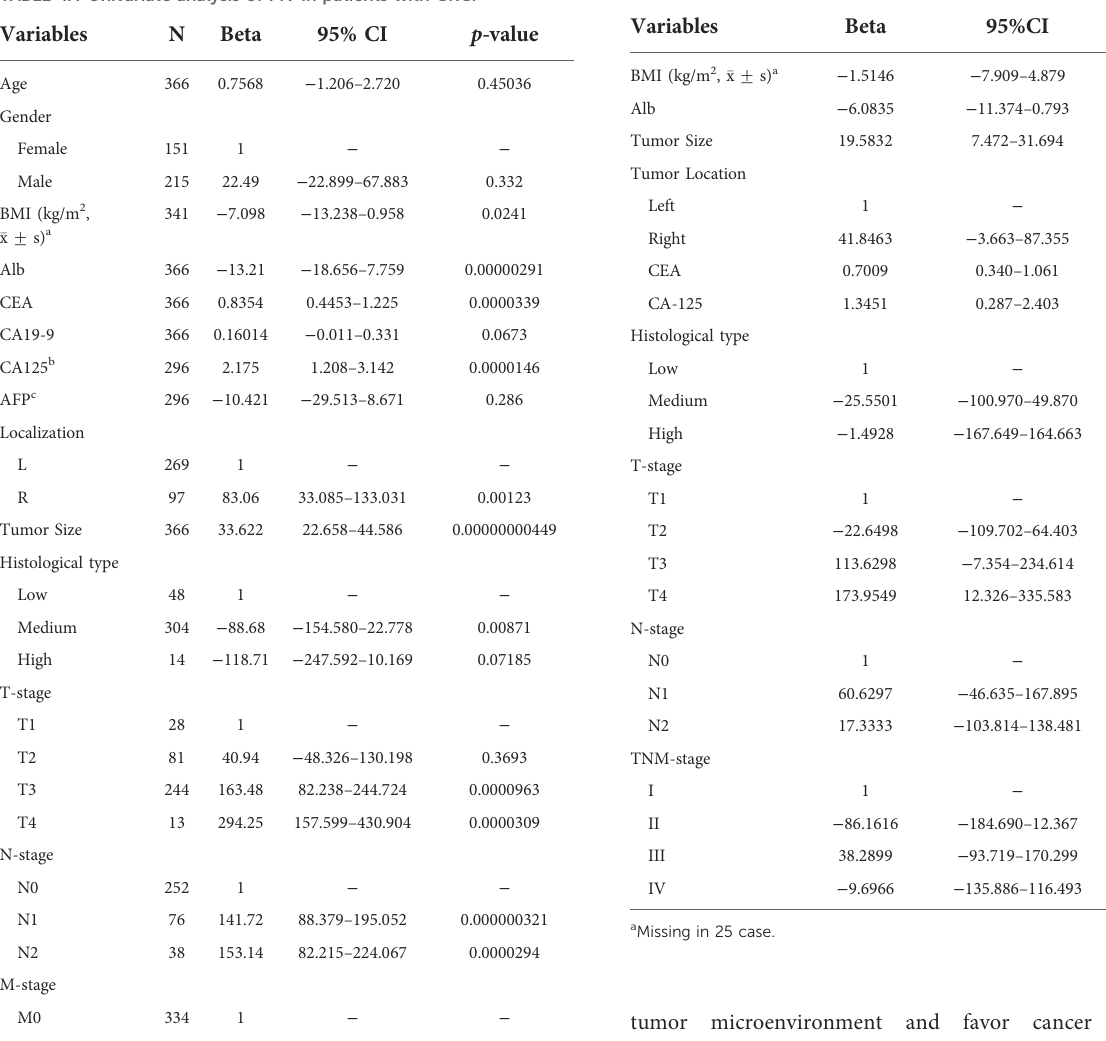
TABLE 4B Multivariate analysis of PIV in patients with CRC. TABLE 4A Univariate analysis of PIV in patients with